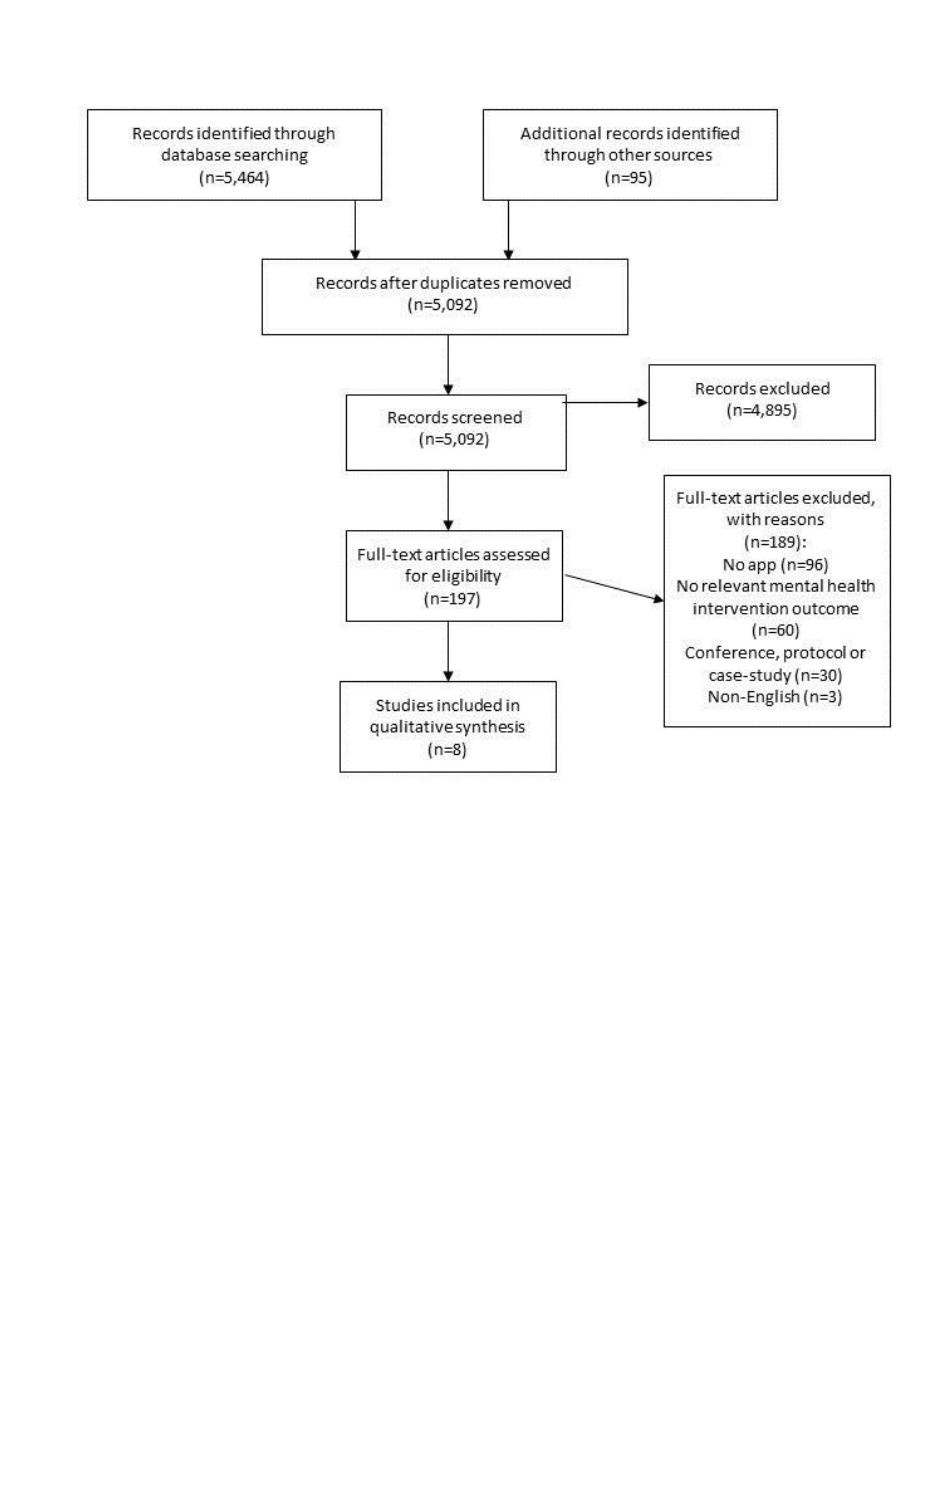
Figure 1. Flow diagram of